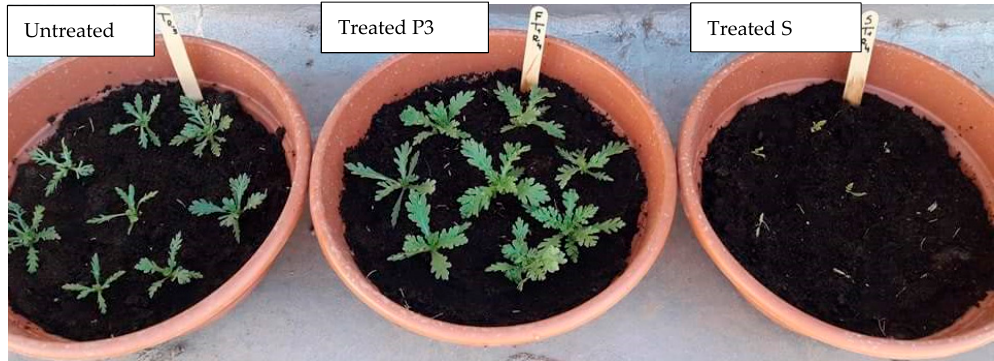
Figure 3. Growth differences among G. coronaria plants observed 10 days after tribenuron-methyl application at field rate. Right, untreated control; middle, treated P3 population; left, treated S population.